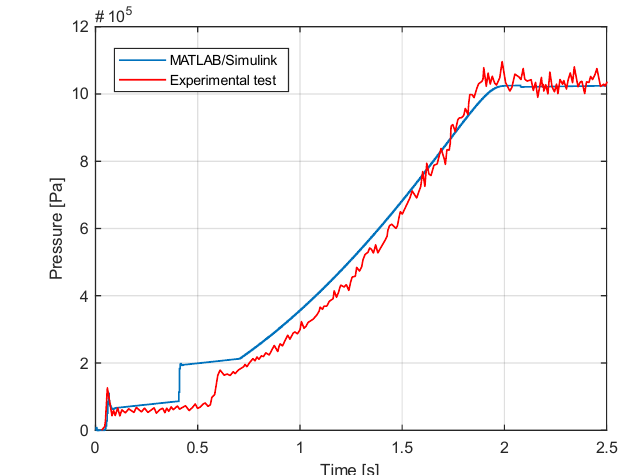
Figure 9 – Comparative presentation of the obtained results – T2 Рис. 9 – Сравнительный обзор полученных результатов – T2 Слика 9 – Упоредни приказ добијених резултата – Т2